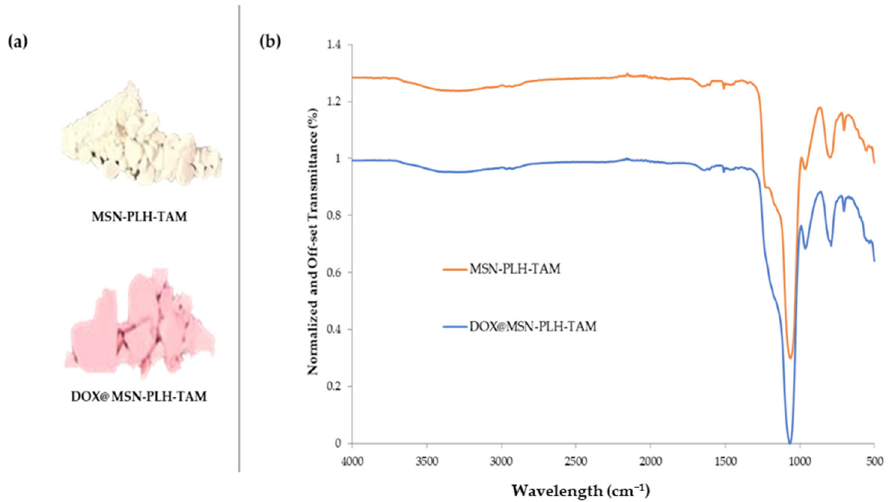
Figure 3. ( a ) Photos of MSN-PLH-TAM vs. DOX@MSN-PLH-TAM, highlighting the colour change upon DOX loading. ( b ) FT-IR spectra of two MSN-based systems. No additional signals were observed following the loading of DOX into the MSN-PLH-TAM.